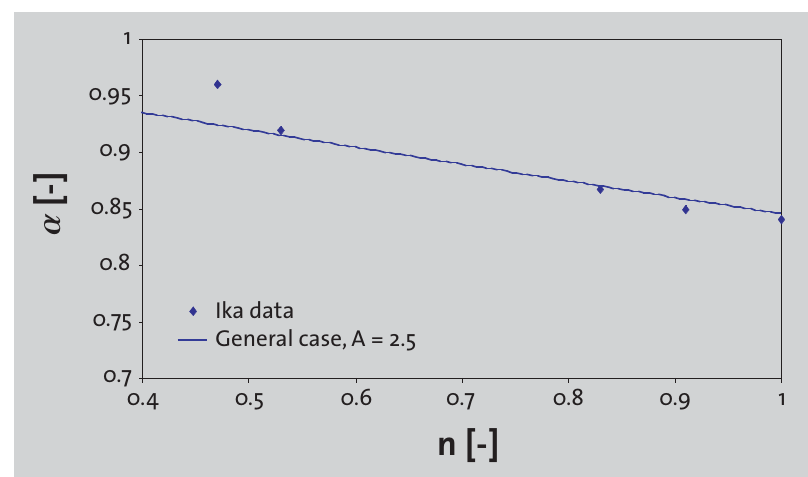
Figure 10: Comparison of kneader data with the general case, A = 2.5, b =